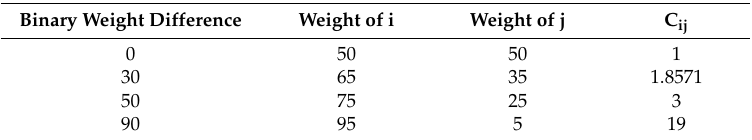
Table 3. Weight allocation of two pairwise comparison and importance ratio C ij .